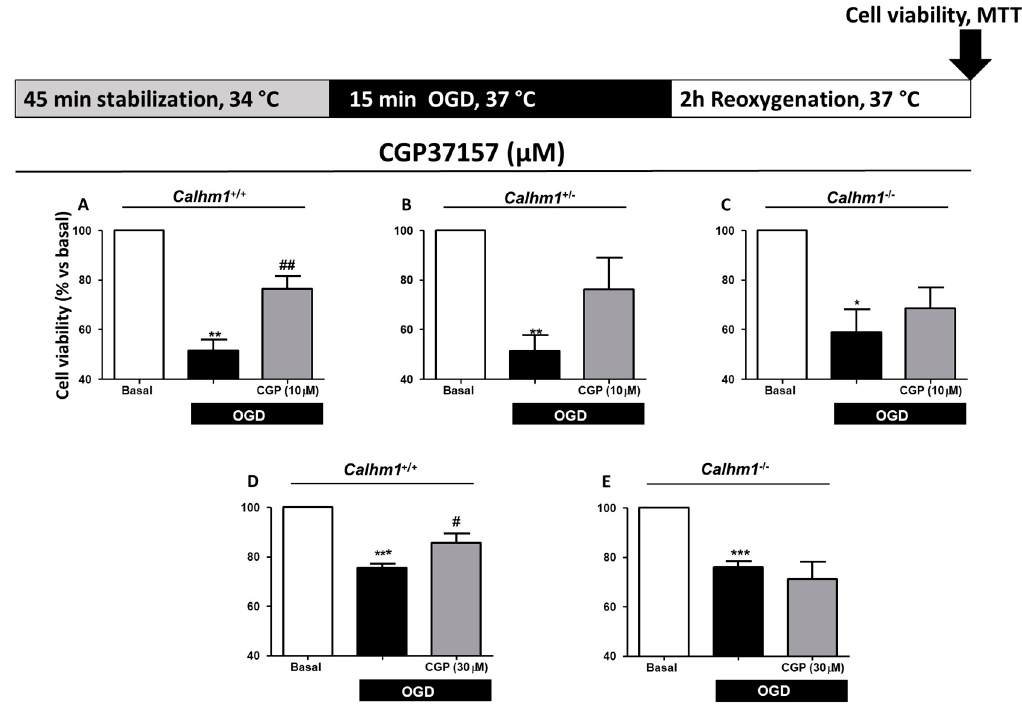
Figure 3. CALHM1 is required for the protective effect of CGP37157 in the model of oxygen and glucose deprivation followed by reoxygenation (OGD/Reox). Representation of the OGD/Reox protocol used on the top of figures A-E. ( A – C ) Cell viability in hippocampal slices of Calhm1 +/+ , Calhm1 +/ − and Calhm1 − / − mice was determined through the MTT method. Treatment with CGP37157 (10 μ M) during the OGD/Reox protocol only provided neuroprotection in Calhm1 +/+ slices ( A ), while this effect was not observed in Calhm1 +/ − ( B ) or Calhm1 − / − ( C ) genotypes. ( D – E ) CGP37157 (30 μ M) only exerted benefits in Calhm1 +/+ slices ( D ), without having an effect on Calhm1 − / − samples ( E ). Data represent the mean ± S.E.M of 3–5 different animals; all variables were run in parallel. *** p < 0.001, ** p < 0.01 and * p < 0.05 compared to basal; ## p < 0.01 and # p < 0.05 respect to OGD. One-way ANOVA followed by Newman–Keuls was performed. Data were normalized to the basal condition which was considered as 100% of viability.